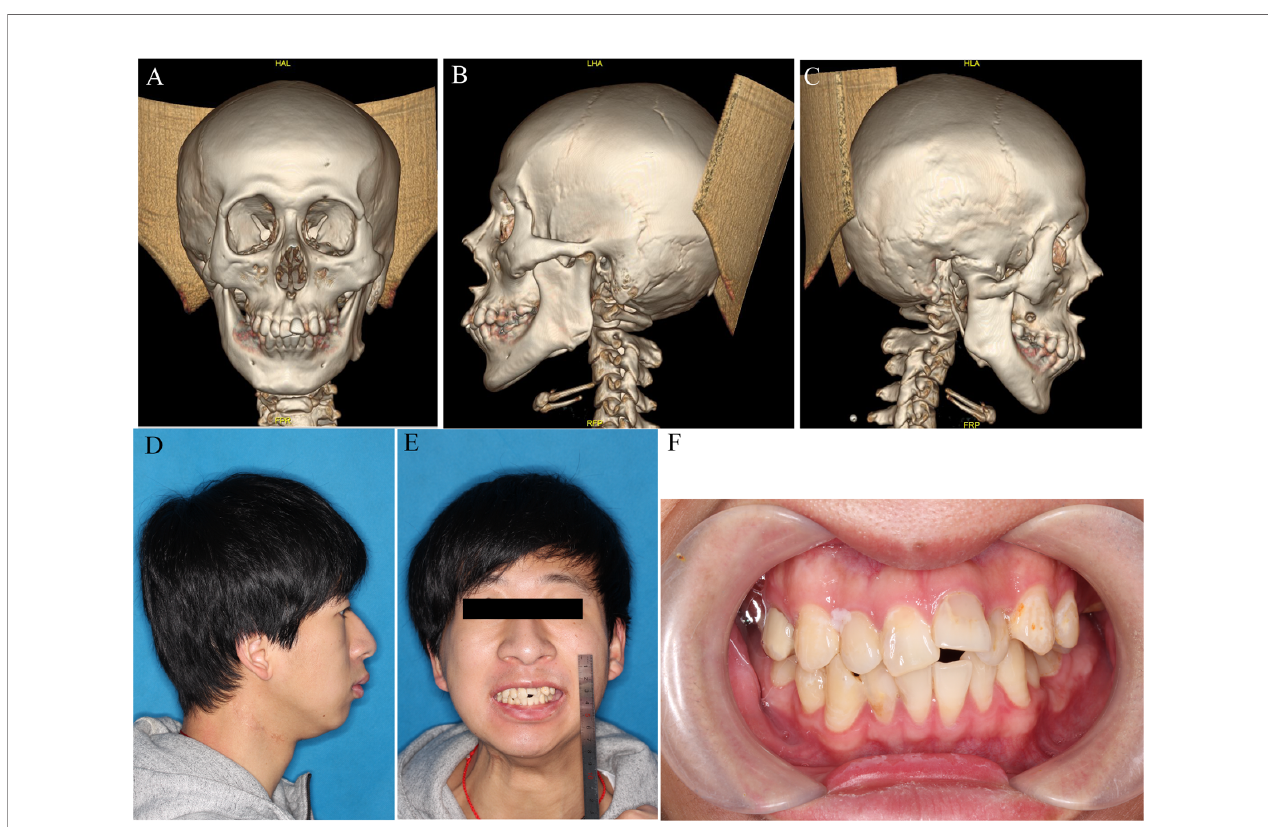
FIGURE 2 | Pre-operative pro fi le. (A – C) 3D reconstruction of bony ankylosis of right TMJ. (D, E) Lateral and front view before surgery. (F) Occlusal relationship before